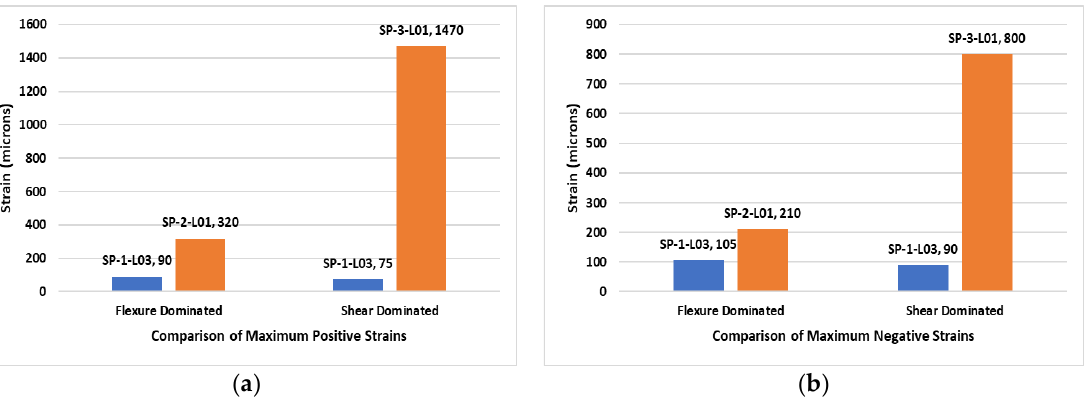
Figure 22. Comparison of strain under four-point service load ( a ) positive and ( b ) negative strain. Comparison between SP-1-L03 and SP-3-L01